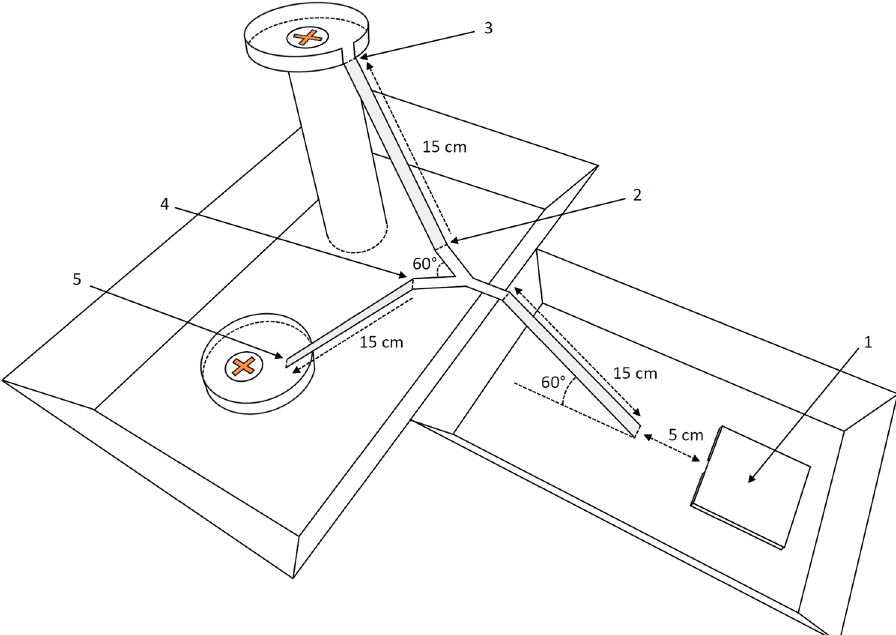
Figure 4. HD experimental setup. The nest (1) and its unique entry (2) facing the first branch of 15 cm leading to the T-maze with ascending and descending branches ( HD setup shown). A syrup feeder (1 M sucrose) was placed on a platform at the end of either the ascending or descending branch of the maze. The number of ants was counted at each food source, and U-turns were measured at point (2) of the ascending branch and (4) for the descending